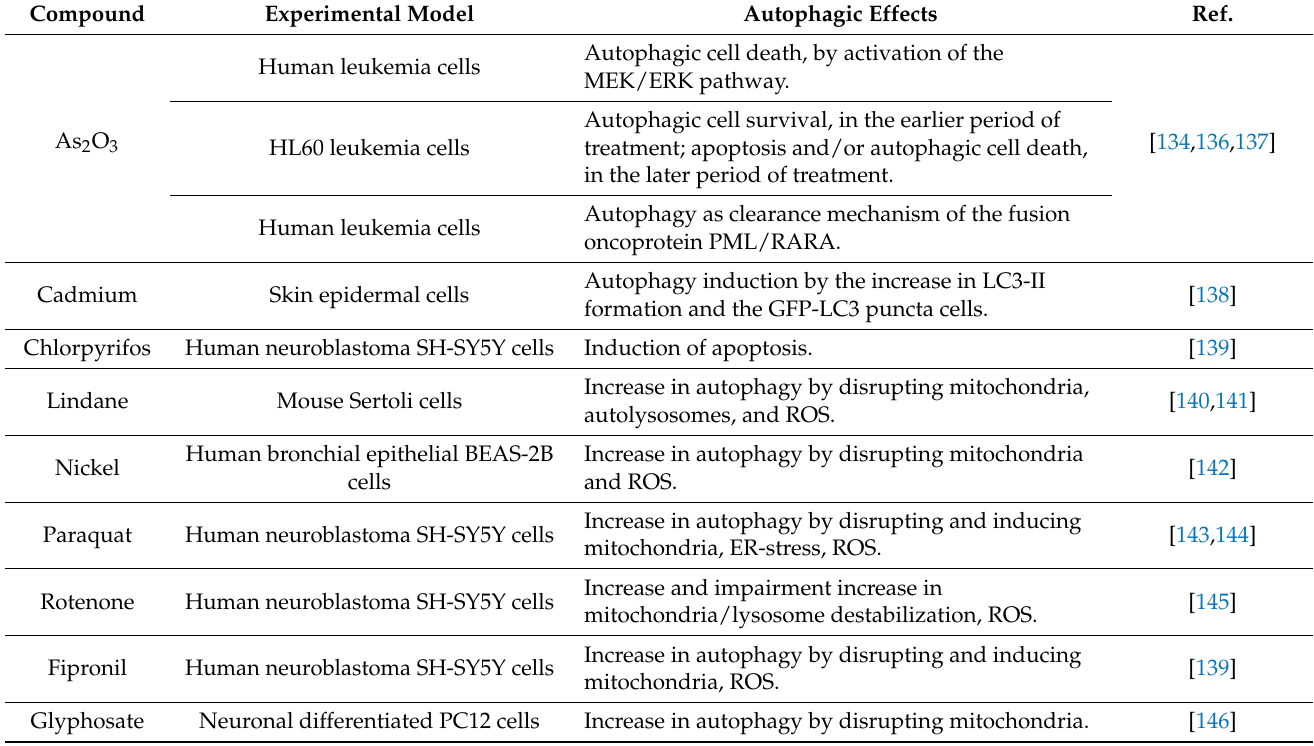
Table 2. List of toxic compounds that induce